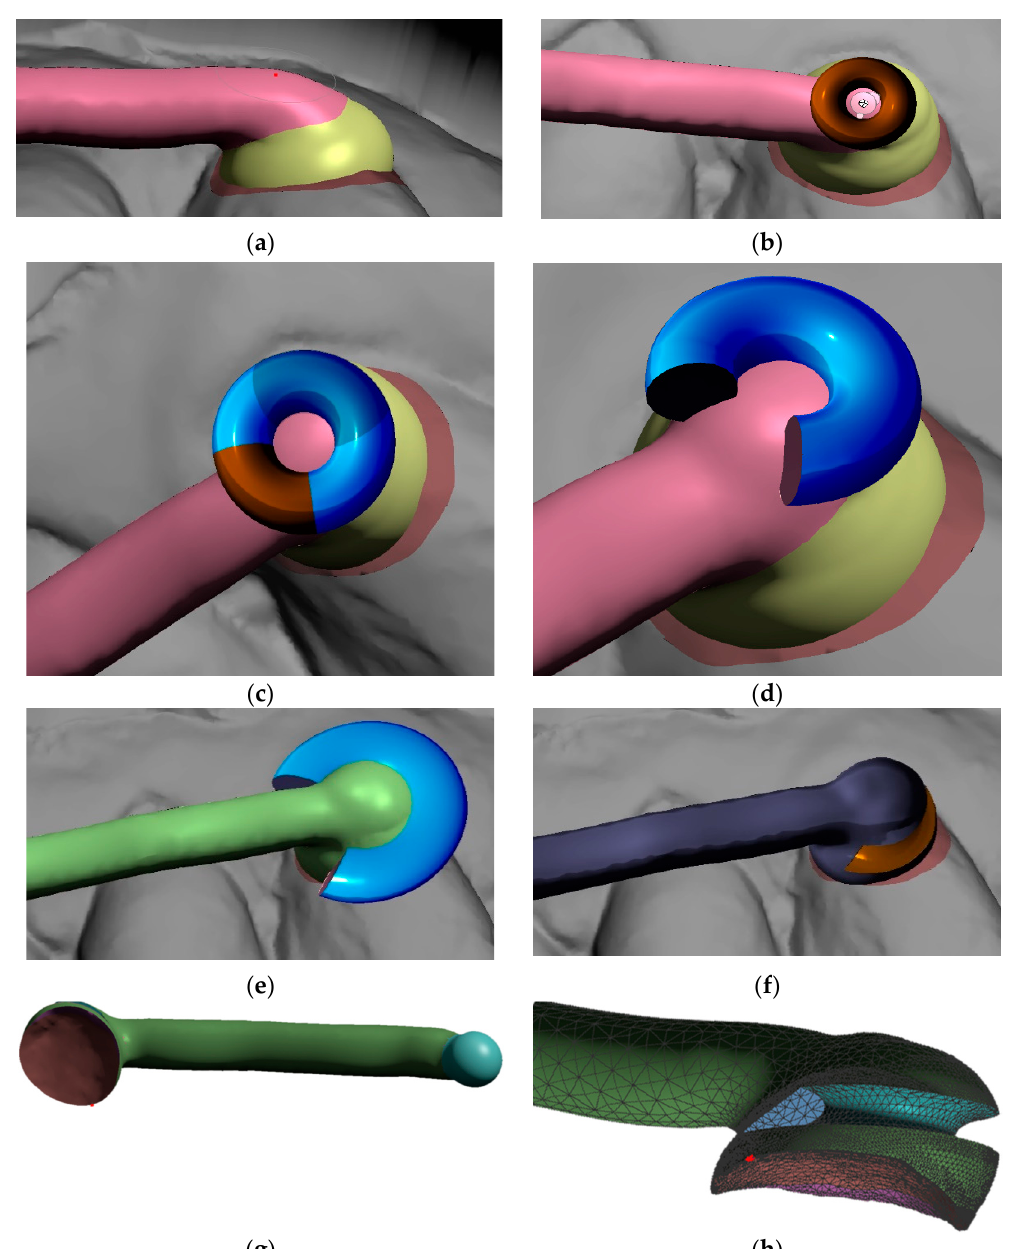
Figure 11. Creation of feature supporting anchorage of the elastic bands. ( a ) Step in connecting area between distalizer’s arm and the canine base is smoothed—different from Figure 9c. The purpose is better comfort and resiliency during chewing; ( b ) Import of a primitive donut shape from basic Meshmixer gallery allows faster subtraction of desired shape for loaded elastic band; ( c ) Quadrant not necessary for elastic retention shall be preserved to increase the strength of this part of the distalizer; ( d ) Reshaping of the reduced donut intended for Boolean subtraction (Select both objects and apply Boolean Difference in a precise Solution mode, preferably using Intersection curves, otherwise default setting in Meshmixer) Quadrant not necessary for elastic retention shall be preserved to increase the strength of this part of the distalizer; ( e ) before subtraction position properly so the long axis of future loaded elastic is pointing towards the lower anchor point—button or precision cut; ( f ) result of Boolean difference subtraction of the adapted donut shape; ( g ) result of Boolean difference between intraoral scan and the canine part of the distalizer—base of the canine pad is now fully individualized; ( h ) profile view of the mesial end of distalizer with the groove intended for the elastic band.